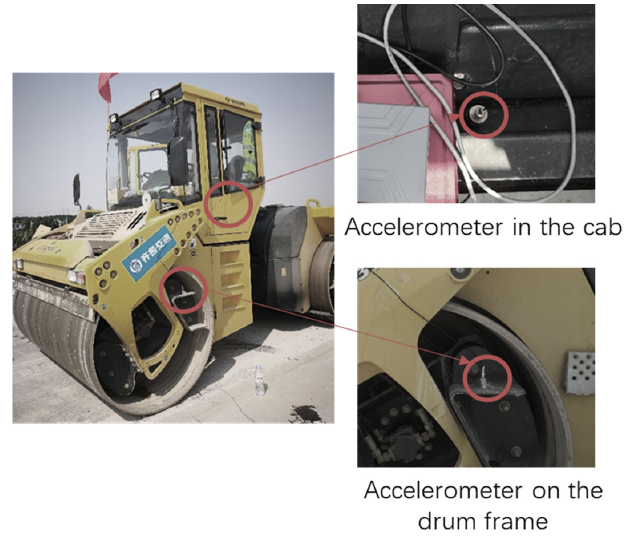
Figure 2. Accelerometer setup.